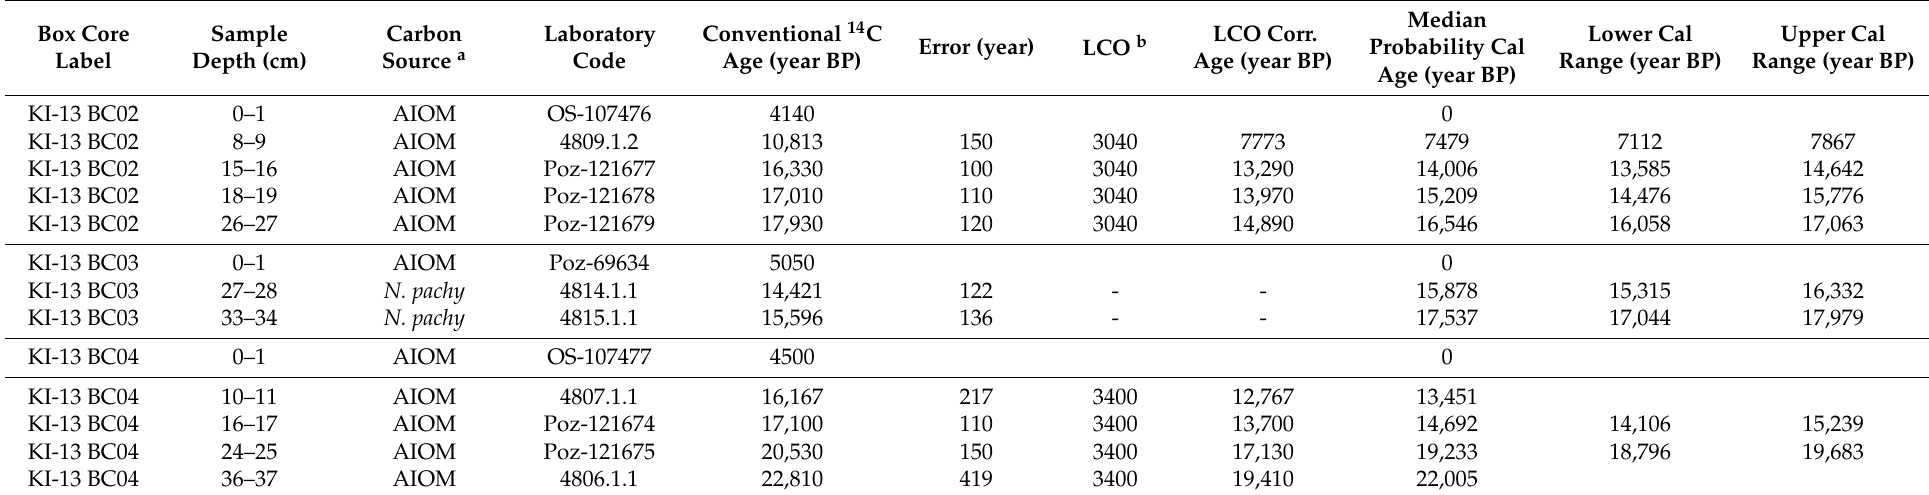
Table 2. Accelerator Mass Spectrometry (AMS) 14 C ages with calibrated calendar ages ± 2 σ (year) and applied local contamination offset and reservoir age correction (see text) of the studied core. The calendar ages were calibrated using CALIB REV 7.1 software [27] with a Marine 13 calibration curve [28]. A constant reservoir correction of 1144 ± 121 years with a ∆ R of 791 ± 121 years [29] was